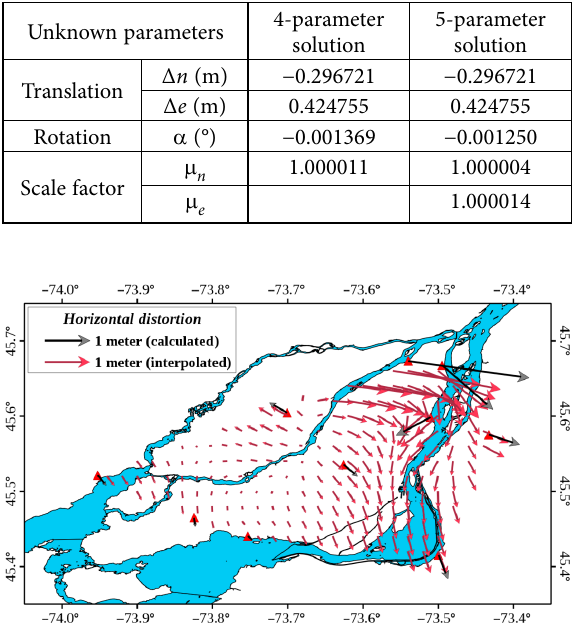
Table 2. Parameters of the similarity transformation